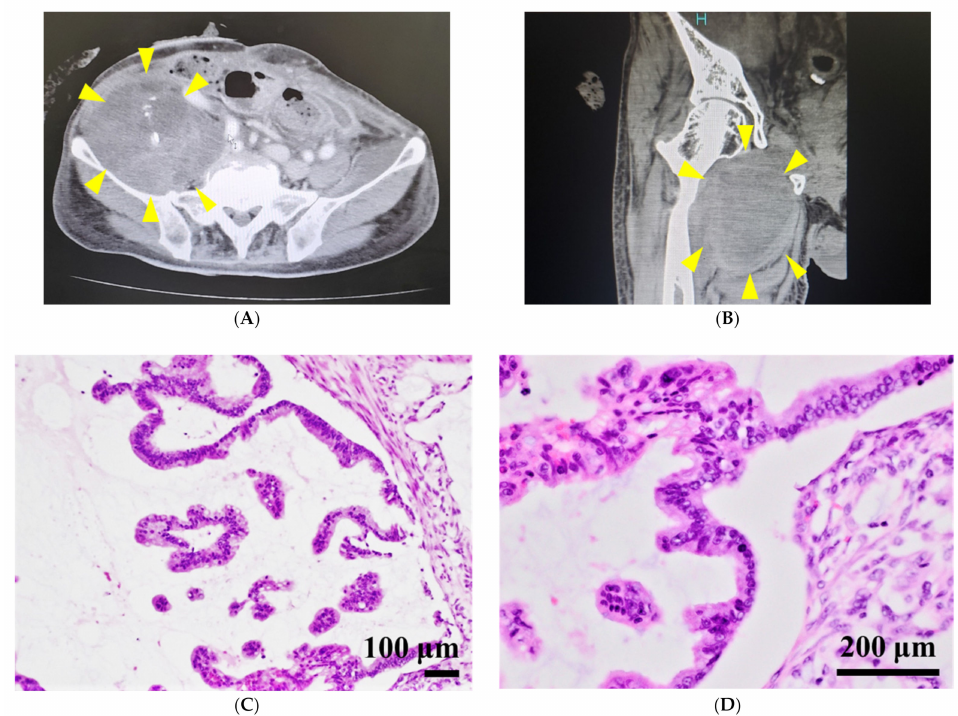
Figure 1. Clinical and pathological findings of the patient with metastatic PMP. ( A ) Intravenous contrast-enhanced CT scans showing a heterogeneously enhancing mass lesion (yellow arrowhead) in an area (diameter: 73 mm) in the right lower abdomen, and ( B ) a heterogeneously enhancing mass lesion in the patient’s right thigh. A hematoxylin and eosin-stained image of the original tumor. ( C , D ). Scale bars indicate 100 µ m ( C ) and 200 µ m ( D